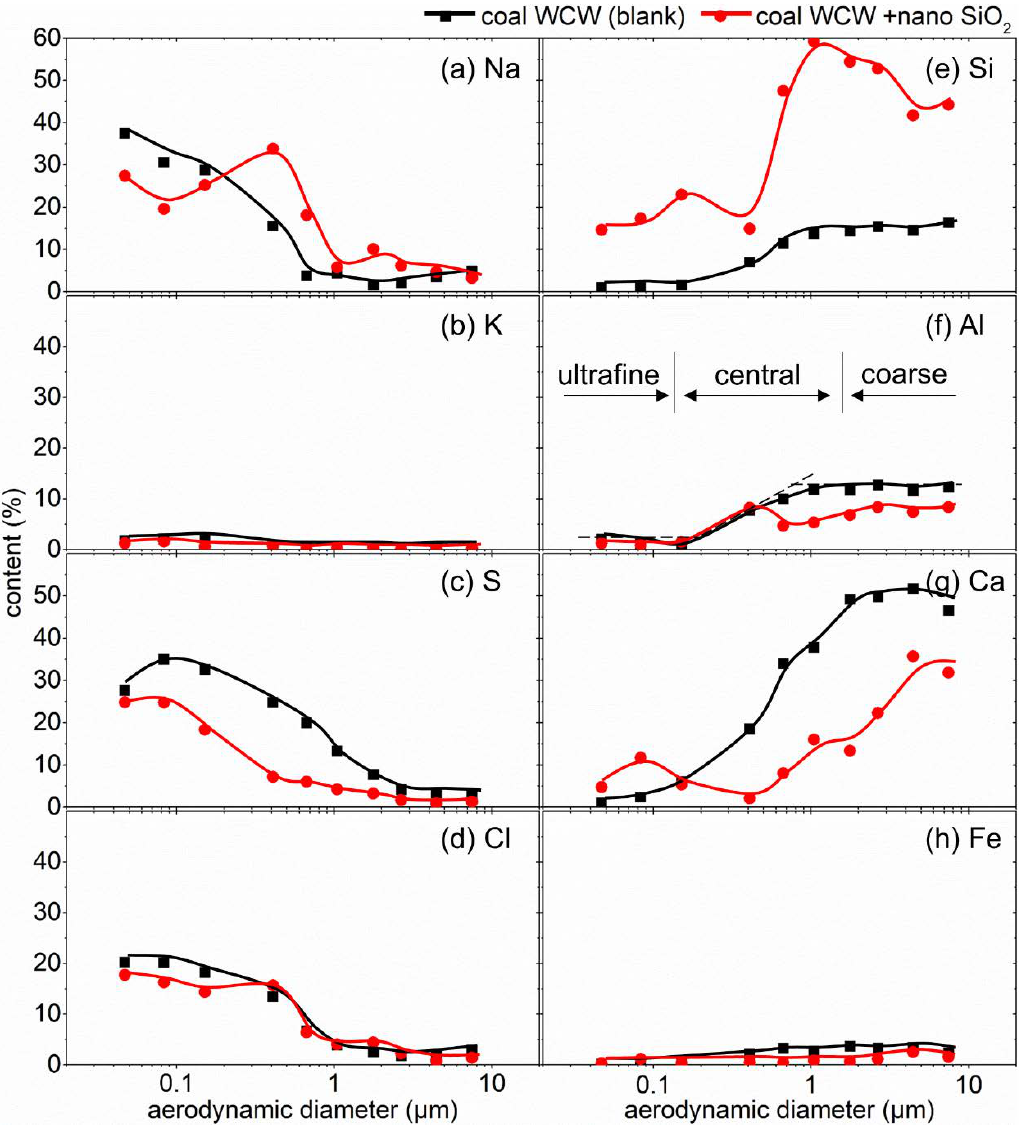
Figure 4. Size-resolved elemental composition distribution in PM 10 generated from coal WCW com- bustion with/without nano SiO 2 addition: ( a ) Na; ( b ) K; ( c ) S; ( d ) Cl; ( e ) Si; ( f ) Al; ( g ) Ca; ( h )